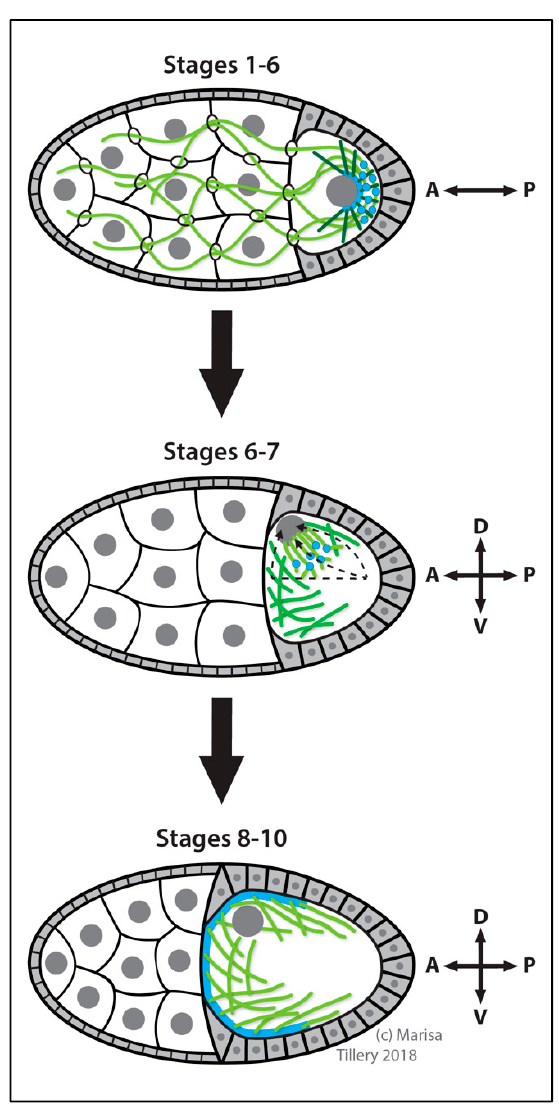
Figure 12. Dynamic changes in MTOCs during oocyte development. In stages 1–6, a cluster of centrioles at the oocyte posterior organizes an MTOC together with a ncMTOC assembled on the posterior hemisphere of the oocyte nucleus. At stage 7, the oocyte migrates to the anterior-dorsal corner of the oocyte and then a new ncMTOC assembles on the anterior cortex. Nuclei are darker grey; MTs are green; centrioles (dots) and other MTOCs are blue.